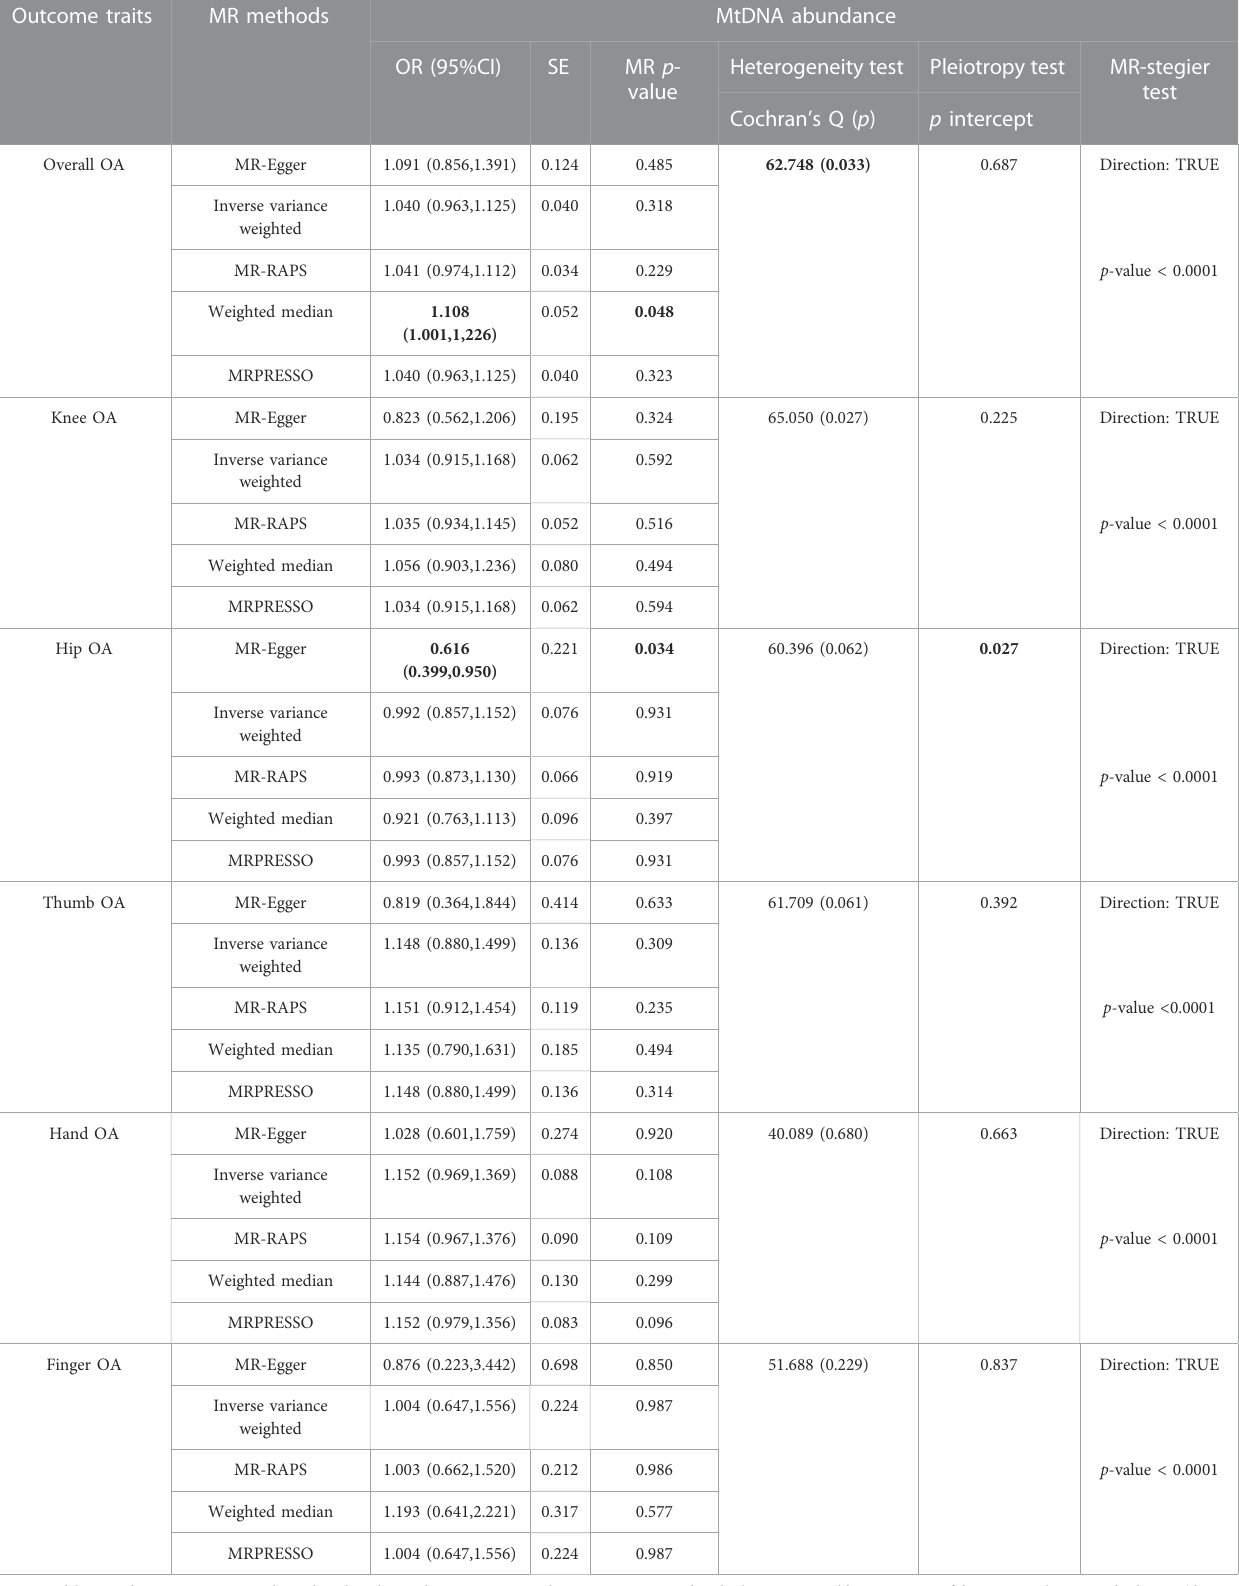
TABLE 2 MR results of causal effect of mtDNA abundance on OA and its other